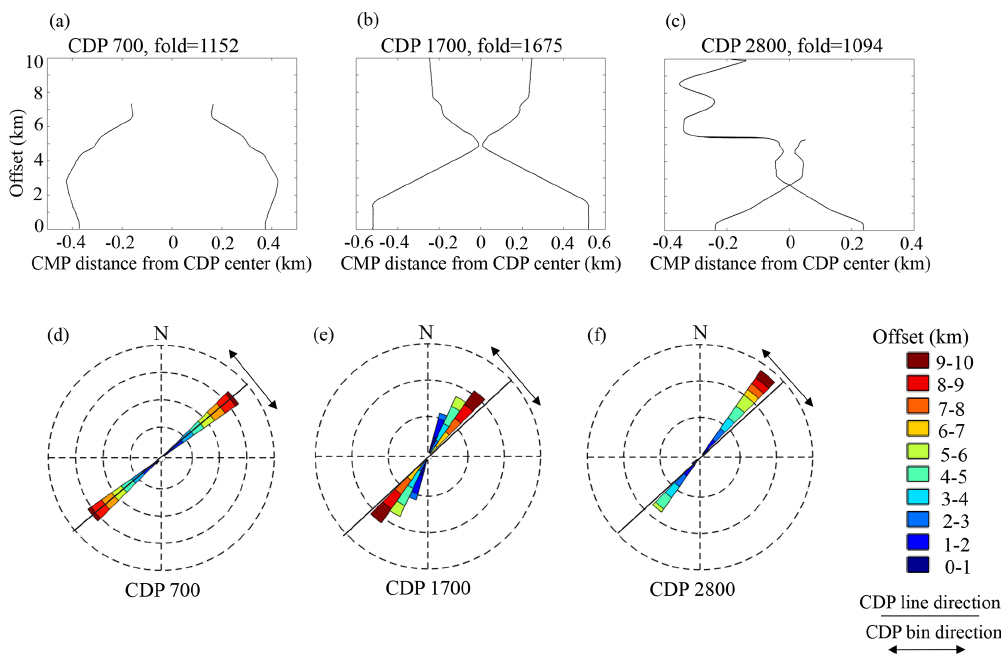
Figure 3. CMP offset and azimuth distribution from the south survey. The offset distribution is shown for (a) CDP 700, (b) CDP 1700, and (c) CDP 2800. See Figs. 1 and 4 for the location of the CDPs. The negative values for CMP distance in graphs (a–c) indicate CMP is located in the south of the bin center and the positive values imply that CMP is located in the north of the bin center. The azimuth distribution is shown for (d) CDP 700, (e) CDP 1700, and (f) CDP 2800. For each diagram shown in (d–f) the CDP line direction is presented. The CDP bin is perpendicular to the CDP